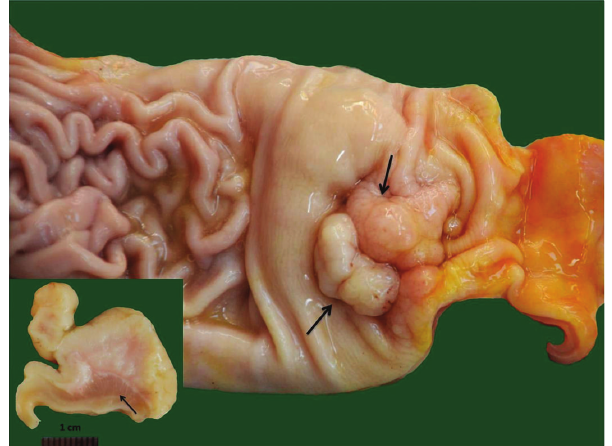
Figure 2: The histological exam of a section of the polypoid mass showing a branching framework consisting of numerous bands of smooth muscle cells (arrow) with intervening glandular tissue and covered by a mild to moderate foveolar hyperplasia. HE stain. Bar = 200 𝜇